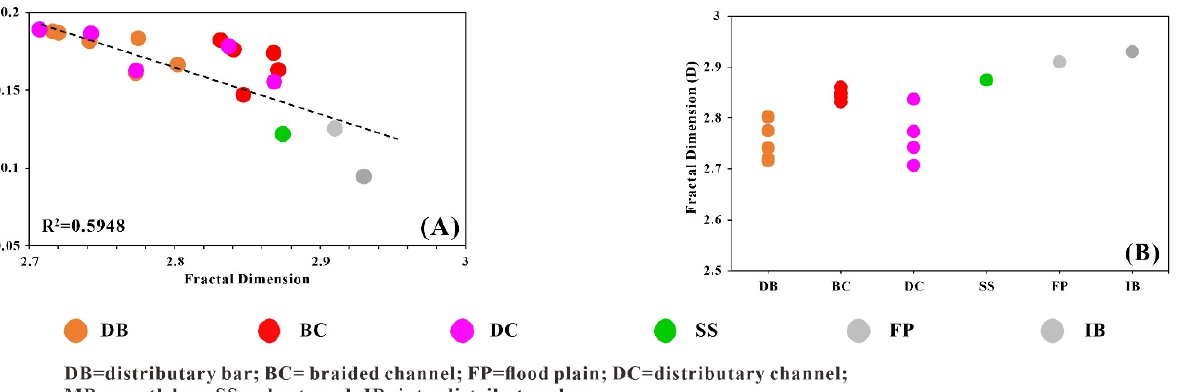
Figure 15. ( A ) Fractal dimension and pore volume scatter plots of different sedimentary microfacies. The pore volume decreases as the fractal dimension increases. ( B ) Fractal dimension of different sedimentary microfacies. With the improvement in reservoir quality, the fractal dimension gradually decreases.